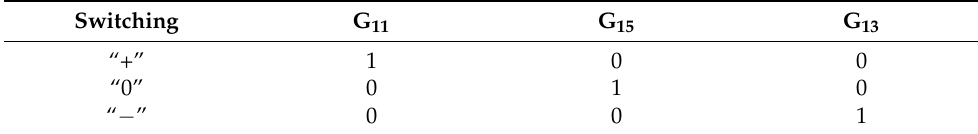
Table 3. ID-NPC switching table.